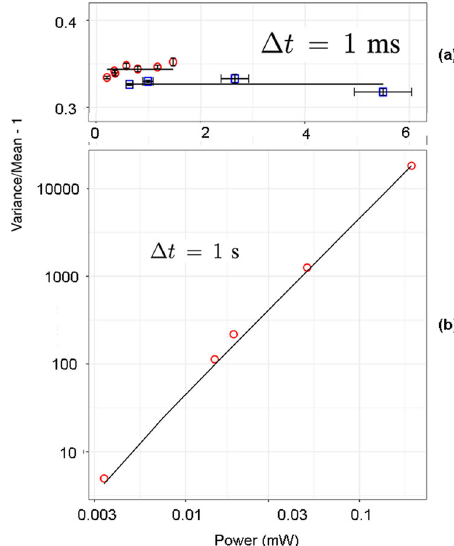
Fig. 4 Variance-to-mean ratio versus reactor power P using the outer NoMAD detectors, for various reactor power levels. The simulation results (red circles) are compared to the Reactor Critical Facility (RCF) experimental data (blue squares) and fi tted by the stochastic model (black lines) for a small time gate ( a Δ t = 1 ms) and for a large time gate ( b Δ t = 1 s). In this last plot, only simulation results are presented as experimental acquisition time for such time gates were out of reach. For small time gates the noise saturates while, for large time gates, it grows unbounded following a P 2 law (up to the recovering of the “ critical catastrophe ” regime) due to vanishing intrinsic sources. Statistical error on variance-to-mean ratio are given by a bootstrap method, both for simulated and experimental data. Relative errors on the power estimation of experimental data were overestimated at 10%, using the detectors calibration. The simulated data of panel b do not have error bars on the variance-to-mean ratio due to insuf fi cient statistics for such large time